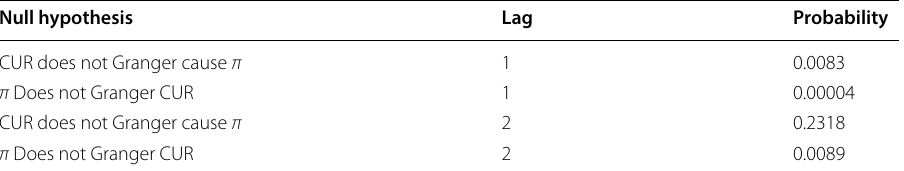
Table 2 Granger causality test results between utilization rate and inflation. Source : Calculated by the author